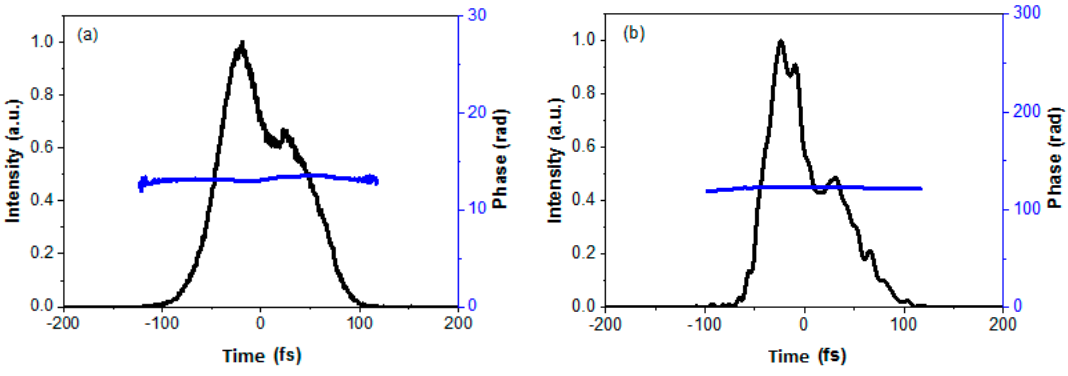
Figure 12. The retrieved intensity profile and phase of ( a ) Beam 1; ( b ) Beam 2